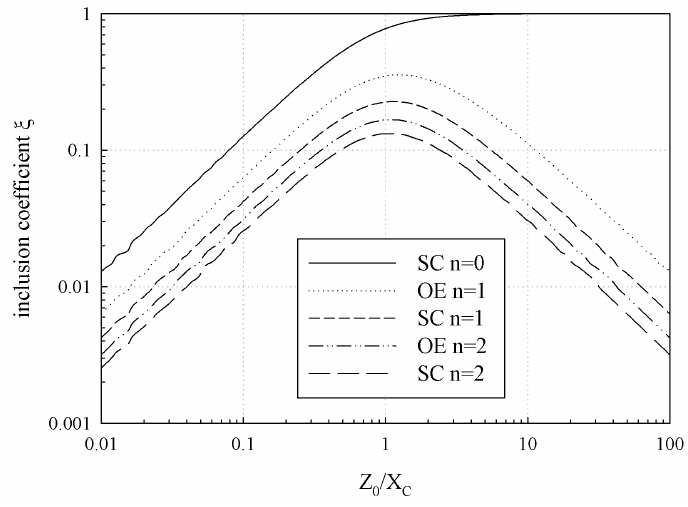
Figure 8. Inclusion coefficient versus Z 0 / X C